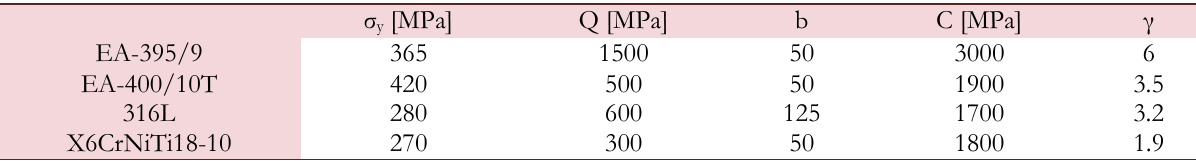
Table 5: Mechanical properties at room temperature.